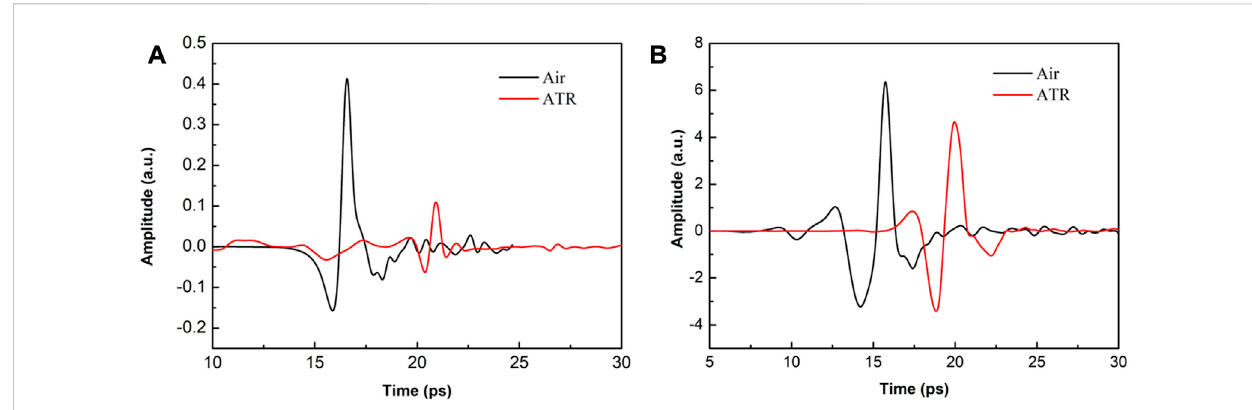
FIGURE 4 THz time-domain spectral comparison diagram of system and no-load ATR prime, when the radiation source is (A) LT- GaAs PCA and (B) high- energy LiNbO3,